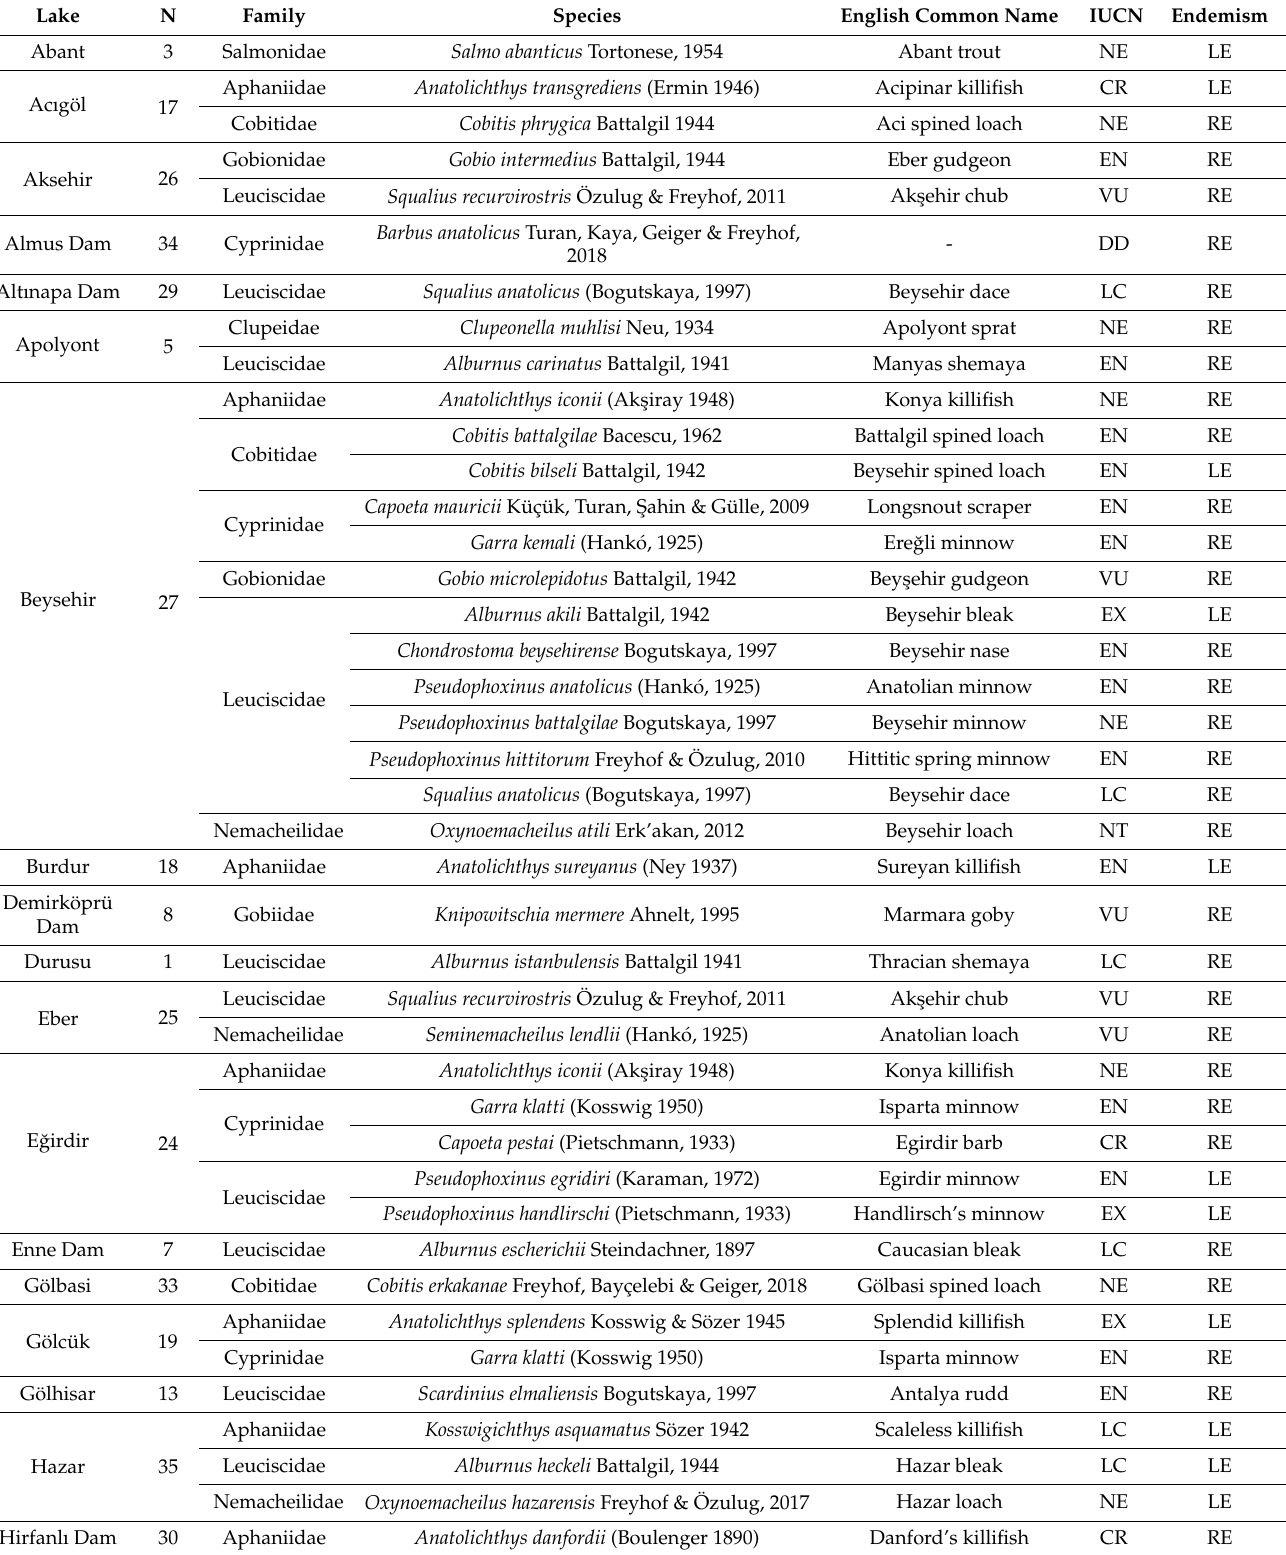
Table 2. List of the freshwater fish species endemic to Turkey reported 1 to occur in the main lakes of Turkey (N: lake number in Figure 1 from West to East; IUCN: IUCN category according to [26]; Endemism: LE: local endemic, RE: regional endemic).